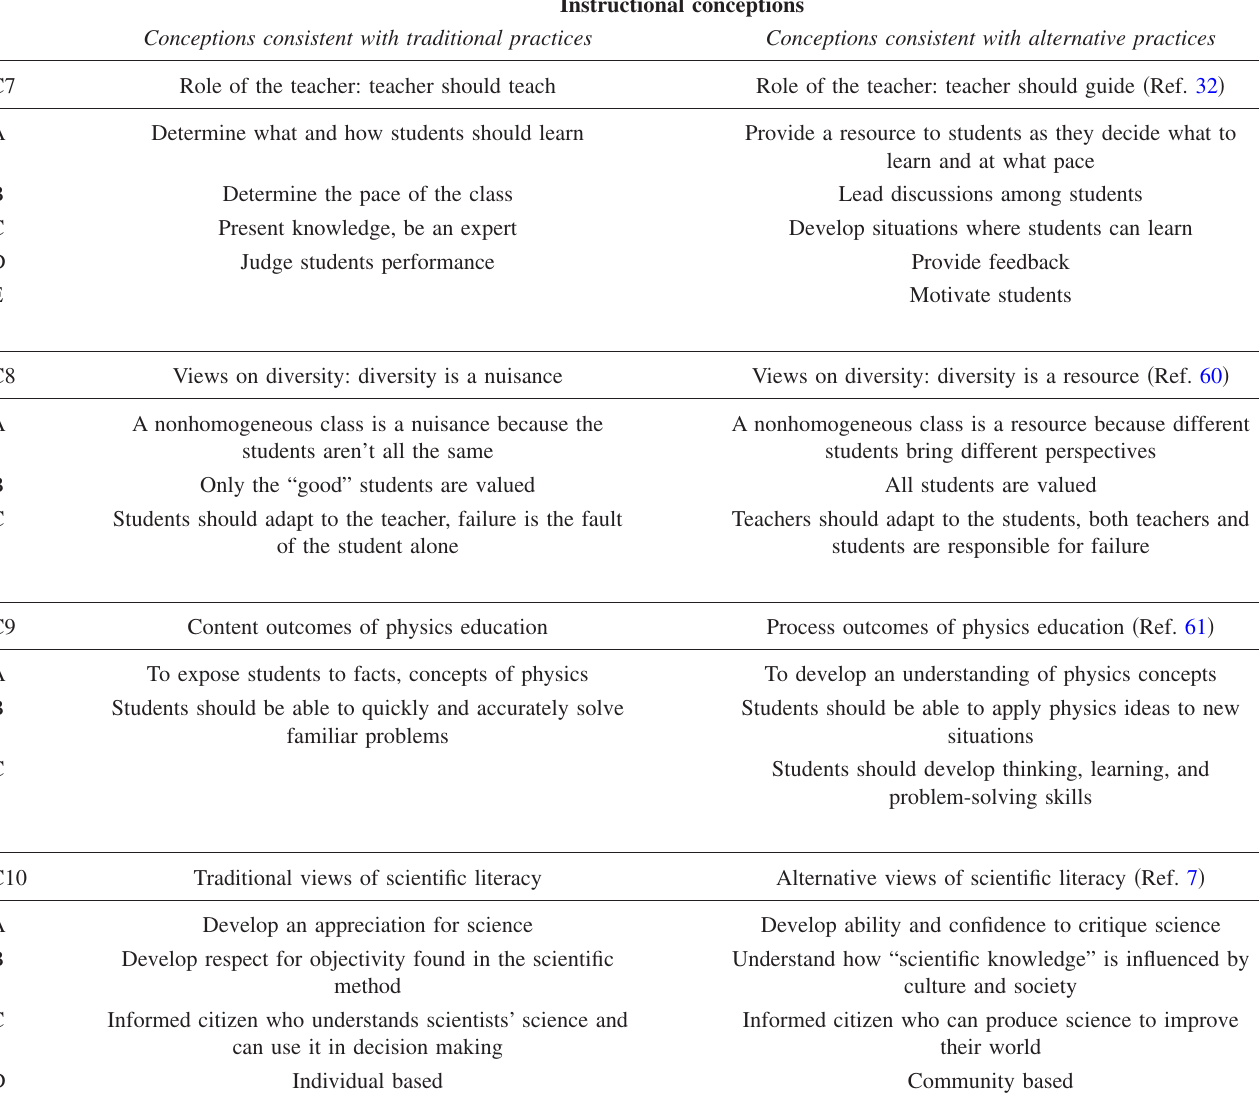
TABLE VI. (cid:1) Continued.